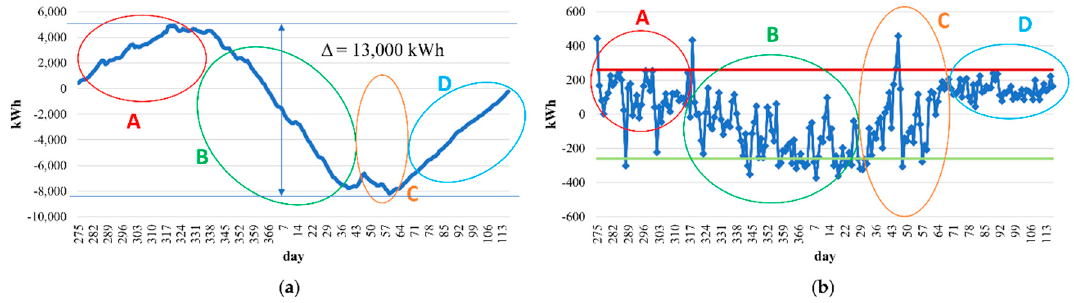
Figure 9. CuSum chart and control chart for the energy performance deviations over a seven month period (daily data): ( a ) CuSum chart; ( b ) control chart for the energy performance deviations.